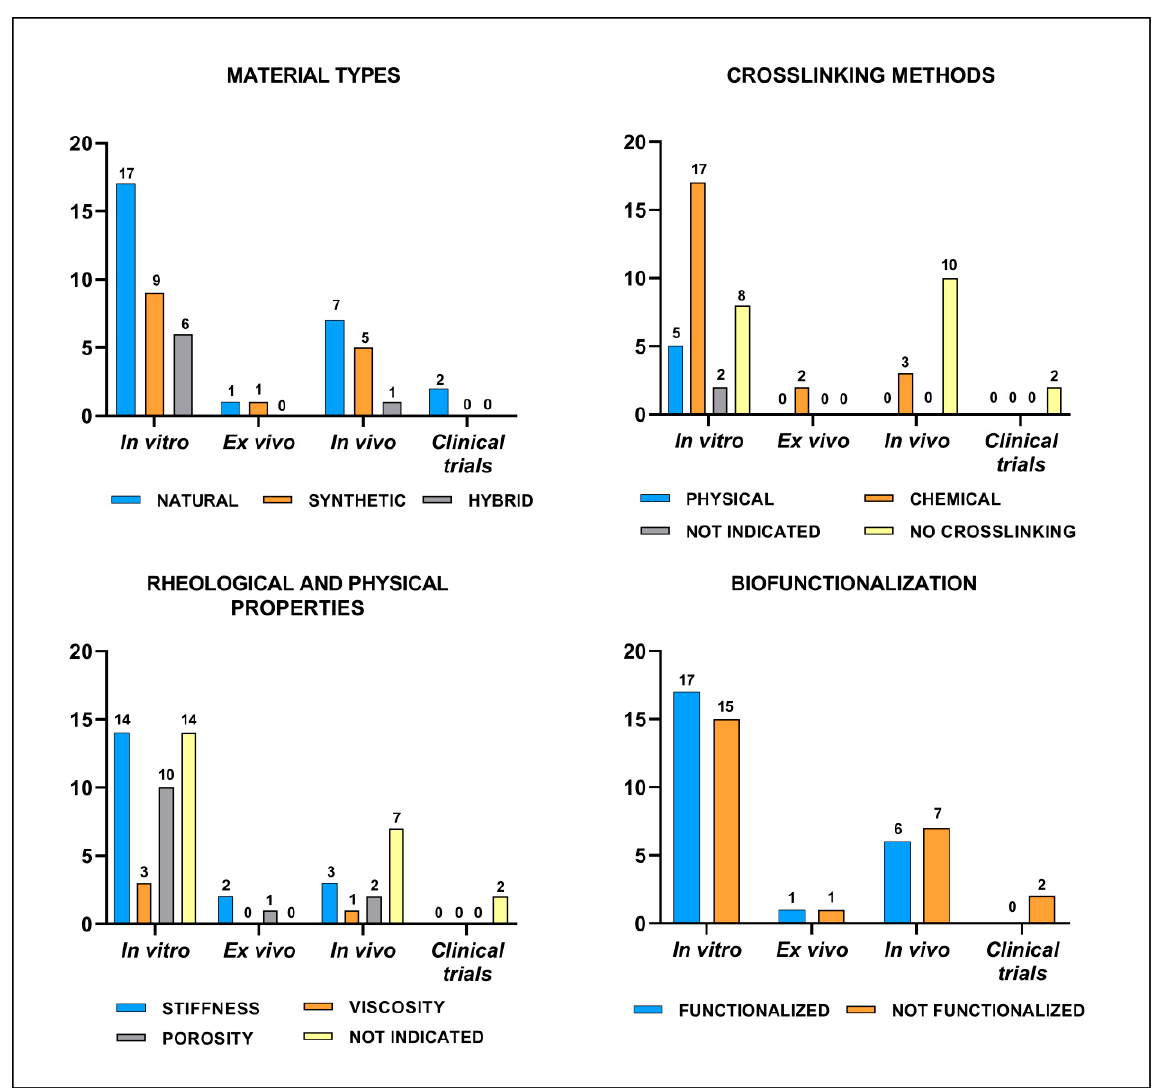
Figure 5. Summary of the main items evidenced in in vitro, ex vivo, in vivo and clinical trials. Histograms represent the number of articles included in the systematic review.